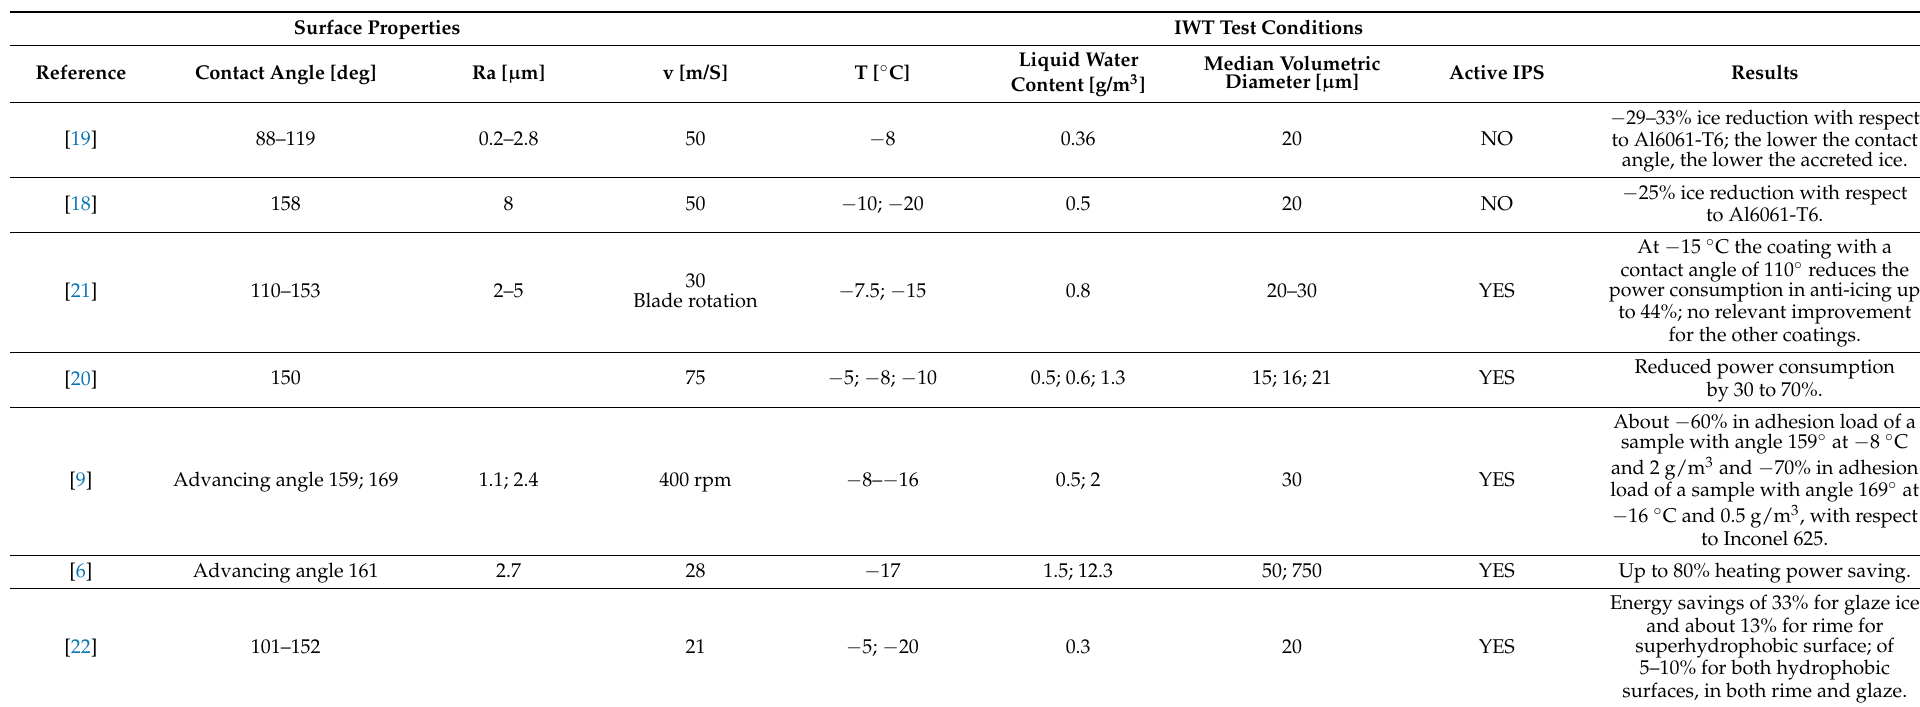
Table 1. Review of Icing Wind Tunnel (IWT) test conditions performed on hydrophobic and superhydrophobic coatings and the main